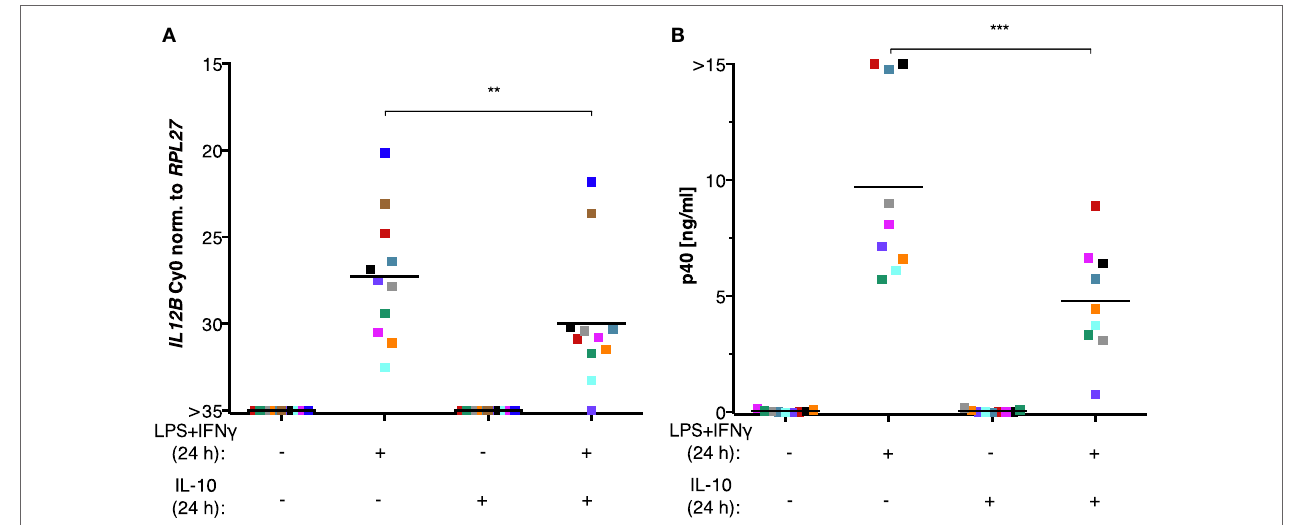
FigUre 7 | IL-10 is not sufficient to suppress IL12B induction in MDMs. MDMs were differentiated in R5 medium for 6–7 days and stimulated with LPS and IFN γ , with recombinant IL-10 from human cells, or both for 24 h. (a) IL12B expression was measured by RT-qPCR ( N = 11). (B) IL-12p40 in culture supernatants ( N = 9) was measured by ELISA. Each square denotes a biological replicate (individual healthy donor). Colors encode individual healthy donors, and colors are consistent between panels within this figure. Median values are indicated by horizontal bars. Statistical significances were calculated with paired t -tests. ** P < 0.01; *** P <